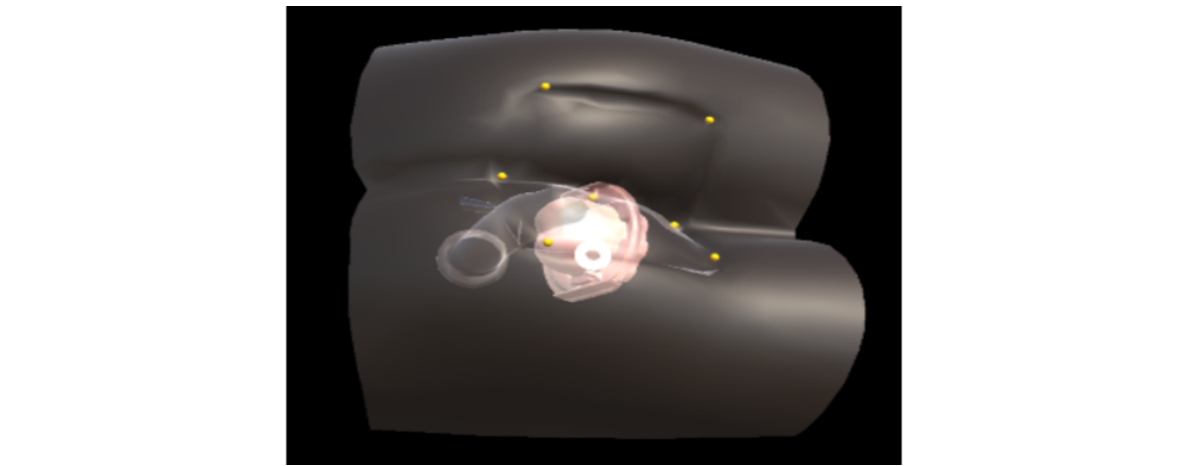
Figure 6. 3D virtual benchtop